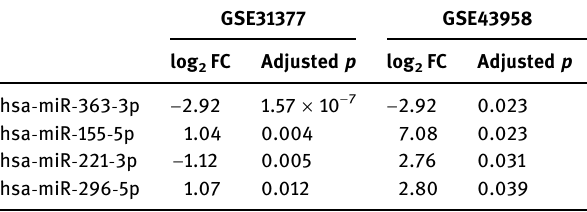
Table 3: The four common DE - miRNAs of GSE31377 and GSE43958 series